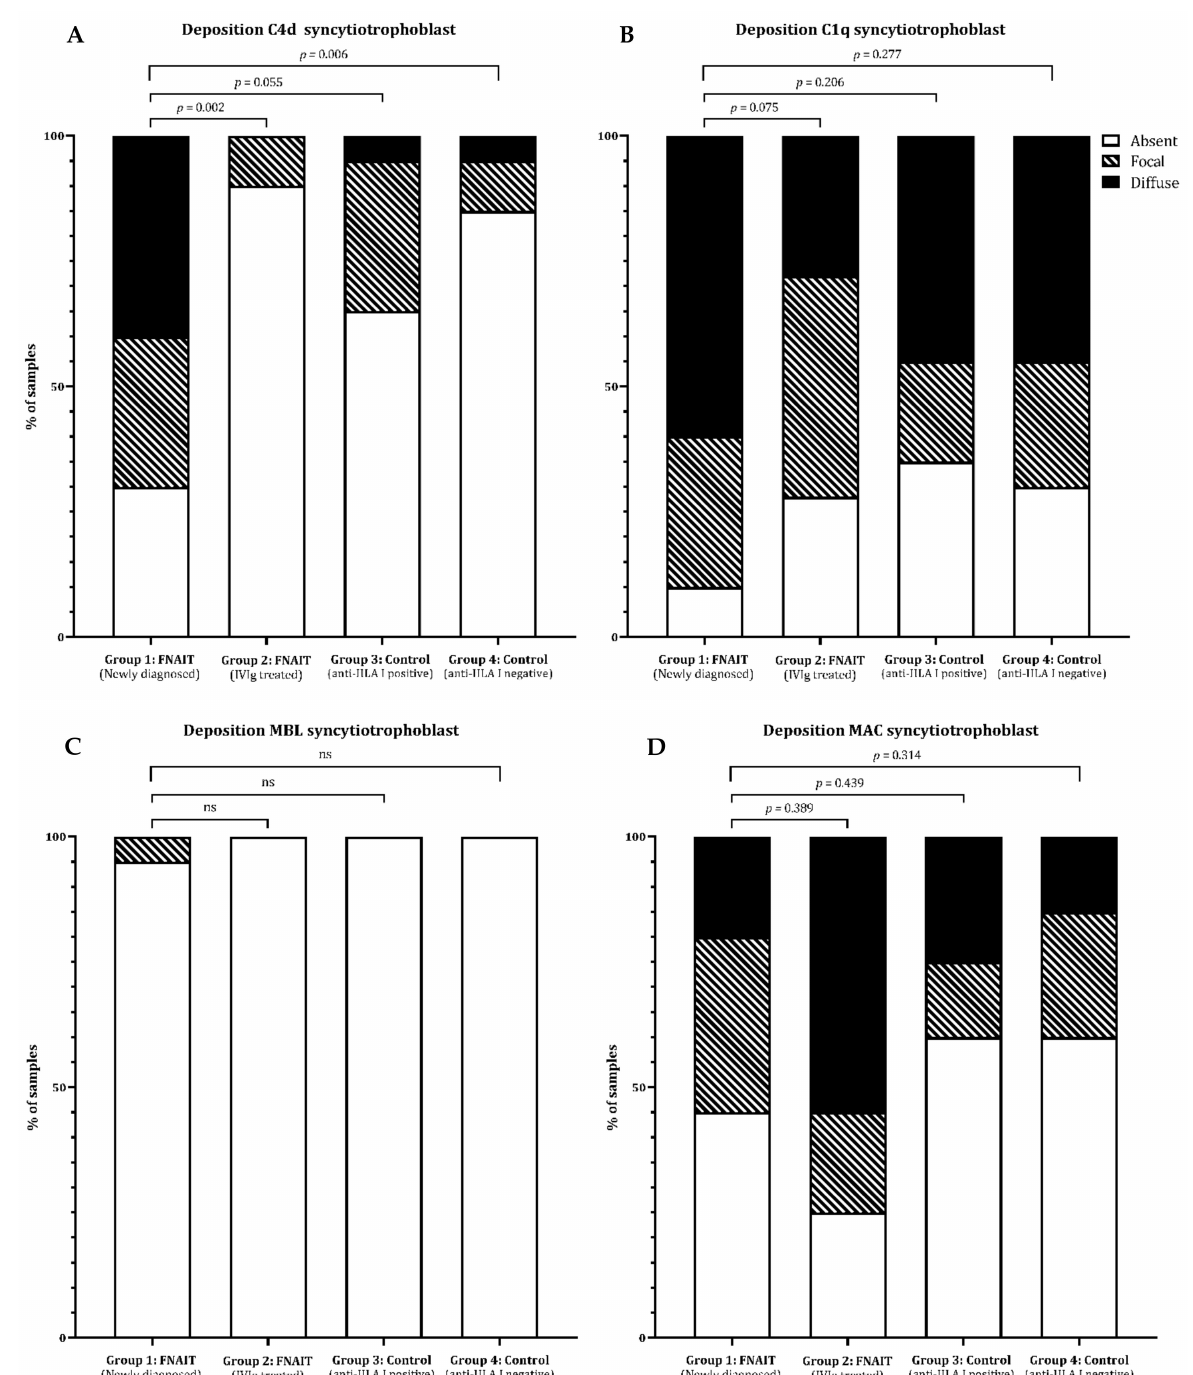
Figure 1. Semi-quantitative scoring of complement deposition syncytiotrophoblast. All complement depositions shown by immunohistochemistry at the syncytiotrophoblast were scored semi-quantitatively as absent (<10%), focal (10–50%), or diffuse (>50%). Figure ( A ) summarizes the scoring of C4d deposition at the syncytiotrophoblast. In Figure ( B ), scoring of C1q deposition, in Figure ( C ), scoring of MBL deposition, and in Figure ( D ), scoring of MAC deposition are summarized. Ordinal logistic regression was used to compare complement deposition score between the groups. FNAIT, fetal neonatal alloimmune thrombocytopenia; IVIg, intravenous immune globulins; HLA, human leukocyte antigen; MBL, mannose- binding lectin; MAC, membrane attack